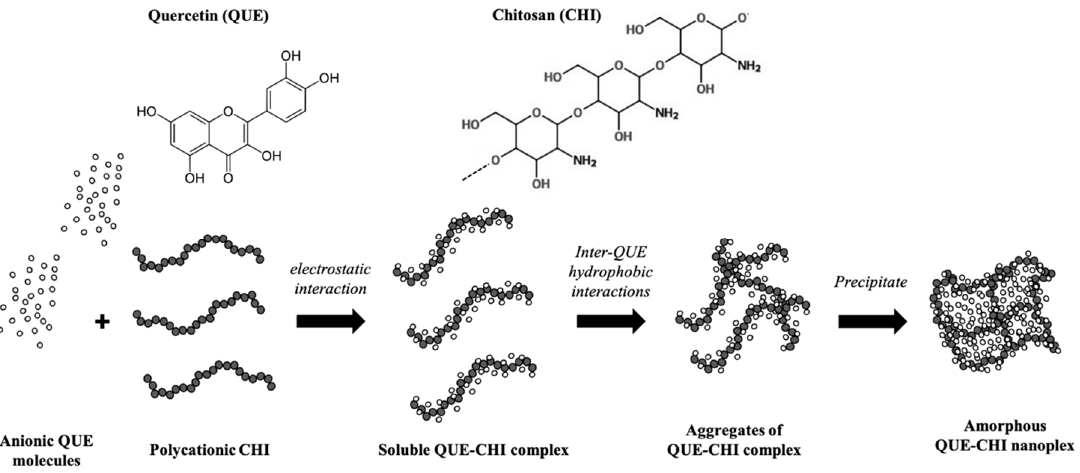
Figure 1. Schematics of the quercetin (QUE)– chitosan (CHI) nanoplex formation.